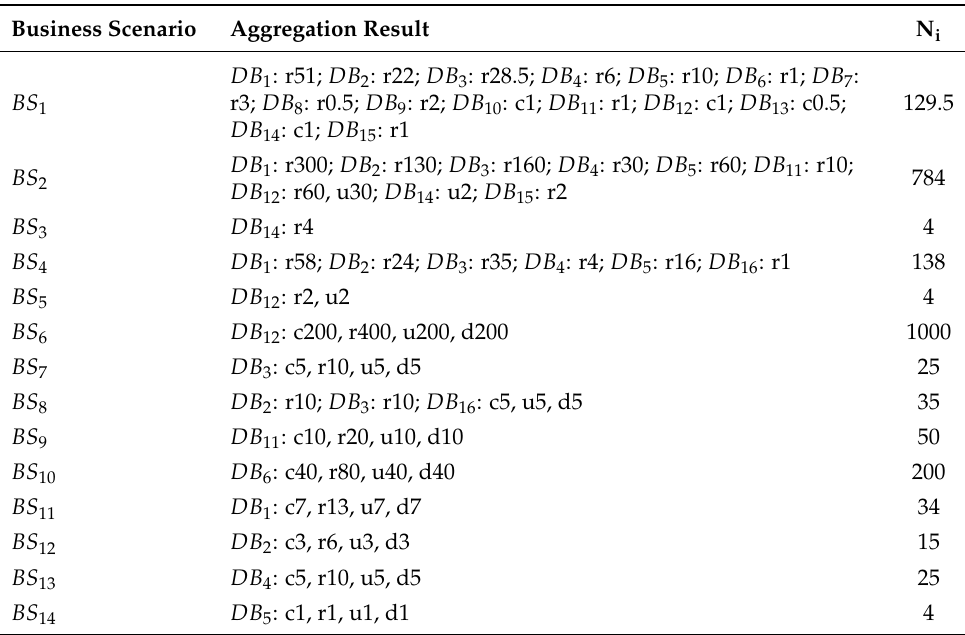
Table 12. The aggregation results of business scenarios in